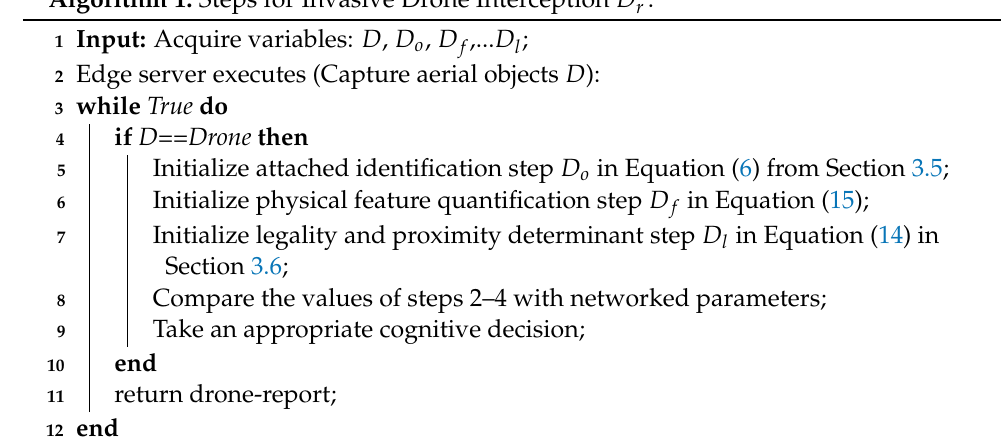
Algorithm 1: Steps for Invasive Drone Interception D d